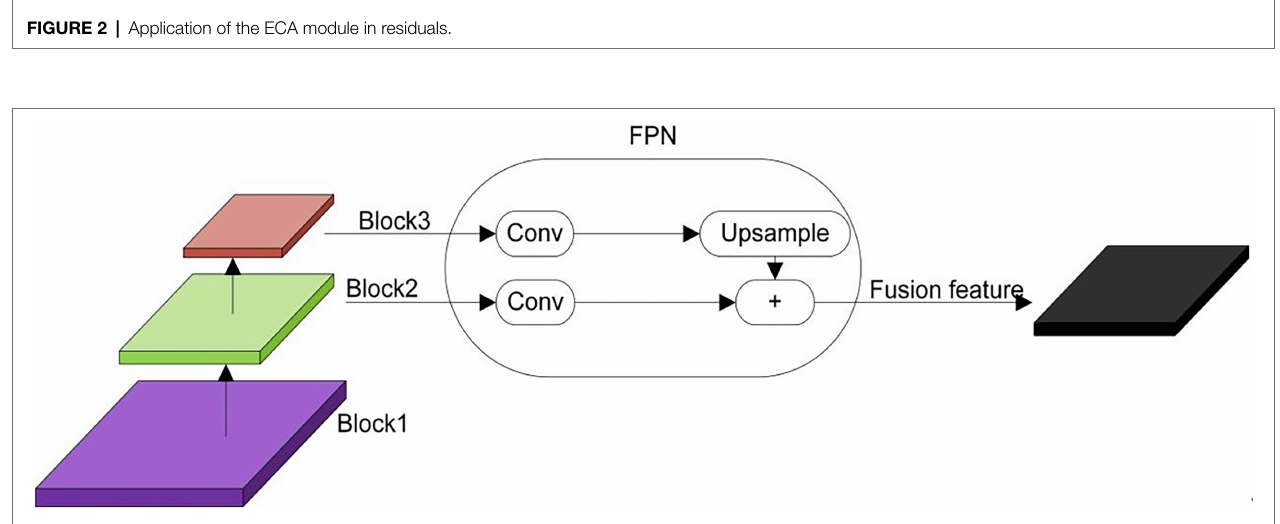
FIGURE 3 | Feature pyramid execution